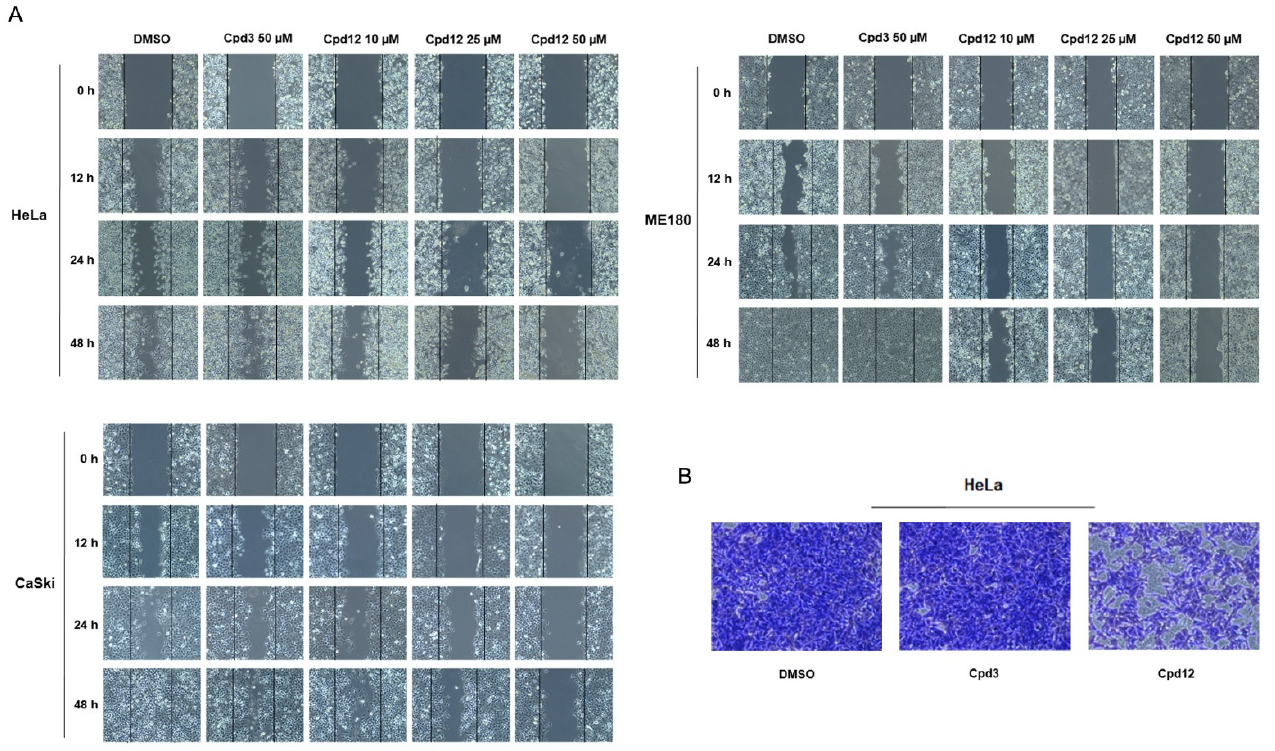
Figure 4. The Cpd12-induced rescue of p53 affects the migration capacity of HPV-transformed cells. ( A ) Confluent monolayers of HeLa, CaSki, and ME180 cervical cancer cells were scraped up two times and then treated with increasing concentration of Cpd12 (10, 25, and 50 µM) in low serum medium. The wound closure was monitored before treatment and after 12, 24, and 48 h, and representative images were taken using a bright-field inverted microscope (100× magnification). ( B ) HeLa cells were treated with Cpd12 (50 µM) for 24 h. Then, cell migration was evaluated by transwell assays after an incubation of other 24 h in Cpd12-free medium. Representative images of migrated cells fixed and colored with crystal violet were taken using a bright-field inverted microscope (100× magnification). In both panels, cells treated with DMSO or Cpd3 (50 µM) were included as negative controls.